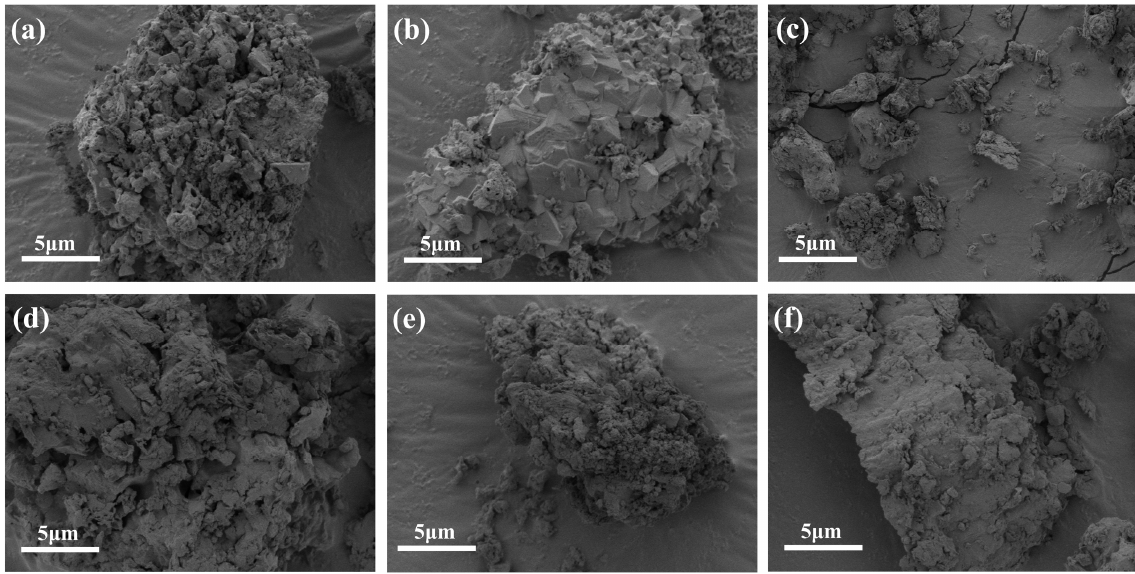
Figure 6. Response surface plots and contour plots of crude sugar yield based on the effect of leach- Figure 6. SEM images of raw sludge ( a , b ), thermal-alkaline pretreated sludge ( c , d ), and sludge with ing time and amount of NaOH addition ( a , b ), amount of NaOH addition and microwave time ( c , d ), microwave combined with thermal-alkaline pretreatment ( e , f microwave time and leaching time ( e , f ).